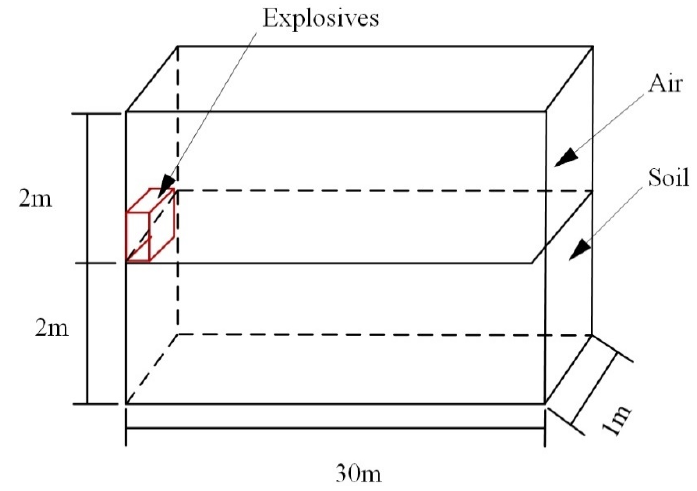
Figure 9. Geometry of the simulated model.